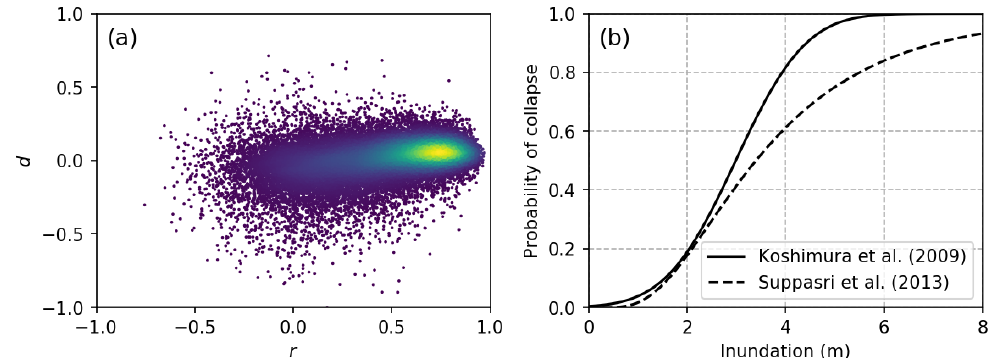
Figure 3. ( a ) Scatter plot of the bi-dimensional dataset composed of r and d values. The colored marks denote the densities at the corresponding points; ( b ) Empirical fragility functions of buildings that collapse due to a tsunami event as proposed by Koshimura et al. [26] (solid line) and by Suppasri et al. [28] (dashed